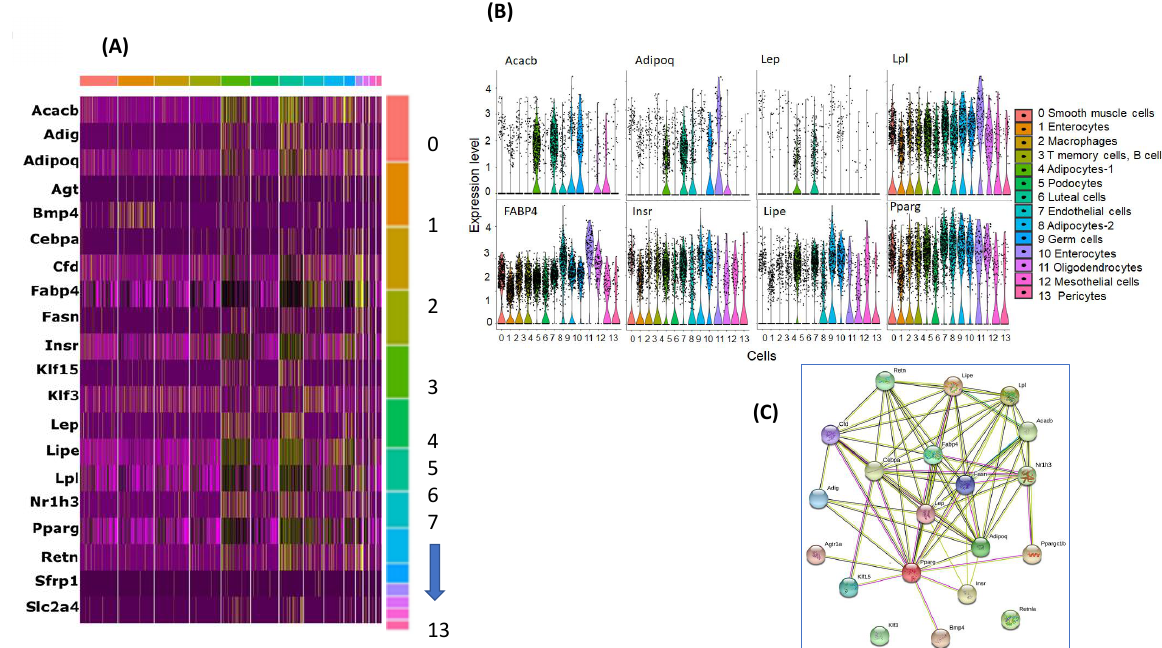
Figure 4. Selected adipocyte and adipogenesis genes in curated list reported in the literature. ( A ) Heatmap of the selected gene expression in each snRNA-seq cell type. ( B ) Violin plots for selected genes and their expression in snRNA-seq in each cell type, assigned by SingleR, using the expression profiles of individual cells. On the x axis, cluster number and y-axis the differentially expressed in RA vs. IH. ( C ) Gene networks of selected genes expressed in adipocytes and metabolic genes in vWAT of mice exposed to IH compared to